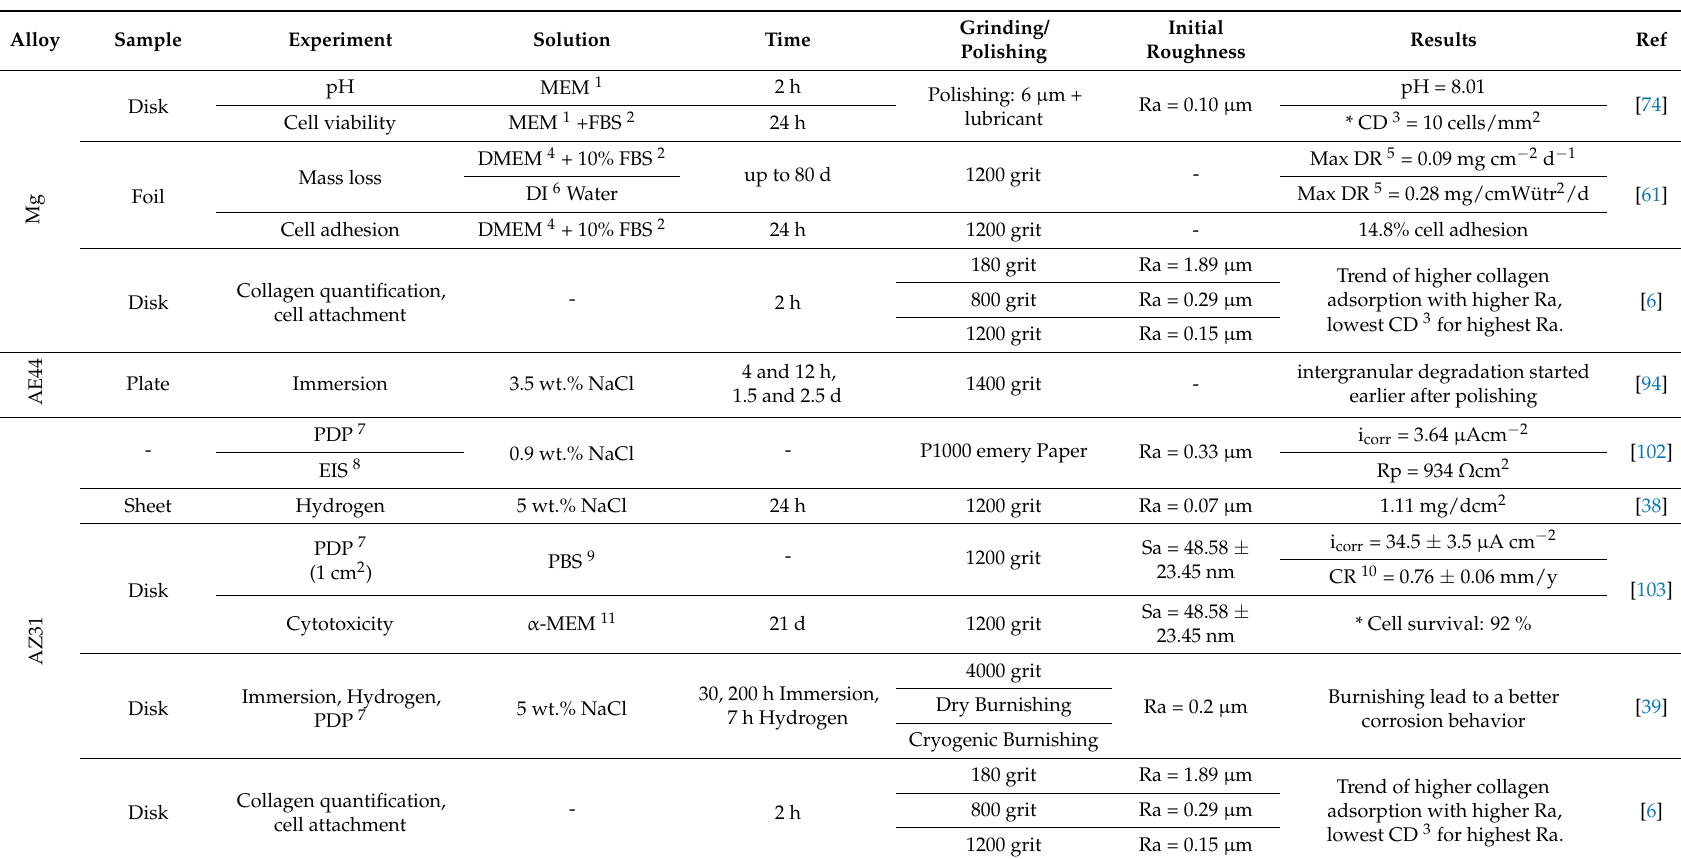
Table 1. Overview of different studies concerning grinding and polishing that consider roughness and degradation behavior. * Values were determined from the diagram with the corresponding